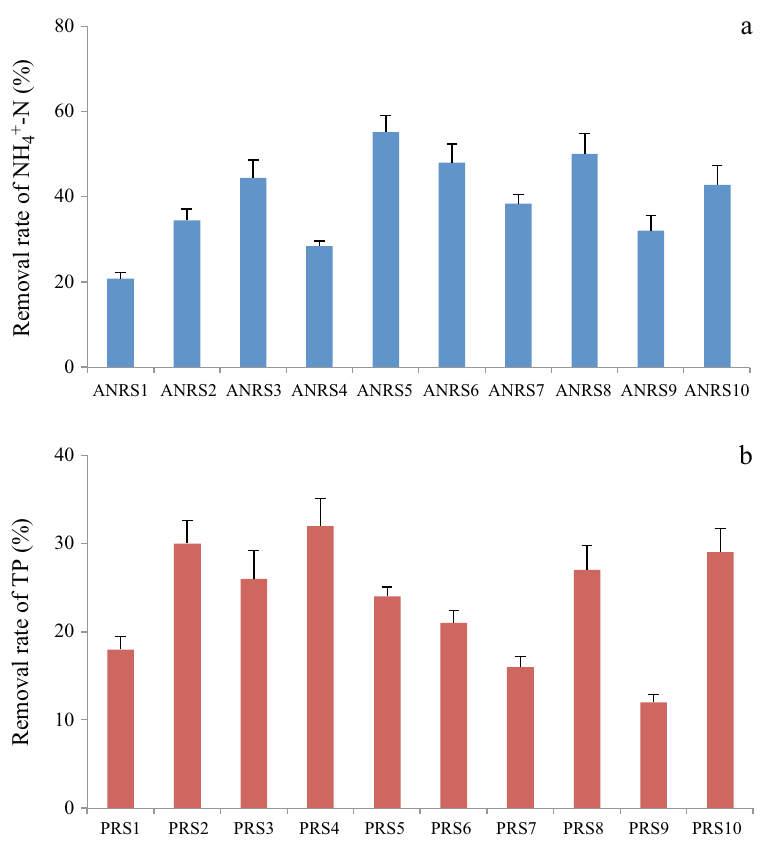
Fig. 3. Comparisons of (a) NH 4+ -N and (b) total phosphorus (TP) removal by different bacterial strains after 48 h at 25°C with initial concentrations of approx. 270 and 130 mg l −1 , respectively. Error bars: